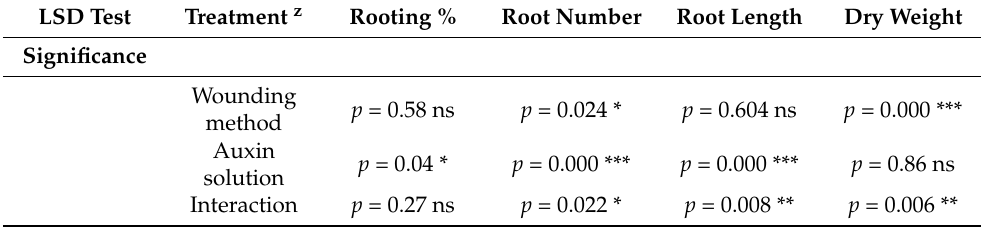
Table 3. Rooting performance of wounding/auxin treatments on stems of F. benjamina in 2020 using two-way completely randomized ANOVA. Performance was evaluated using four indices: (1) rooting rate; (2) root number; (3) root length; and (4) root dry weight. Lowercase letters indicate significant differences among treatments for a given trait ( p < 0.05; LSD test). ns, *, **, or ***: nonsignificant or significant at p < 0.05, 0.01, or 0.001, respectively. There was significant interaction between wounding methods and auxin solution factors. LSD Test Treatment z Rooting % Root Number Root Length Dry Weight Significance Wounding p = 0.58 ns p = 0.024 * p = 0.604 ns p = 0.000 *** method Auxin p = 0.04 * p = 0.000 *** p = 0.000 *** p = 0.86 ns solution Interaction p = 0.27 ns p = 0.022 * p = 0.008 ** p = 0.006 **